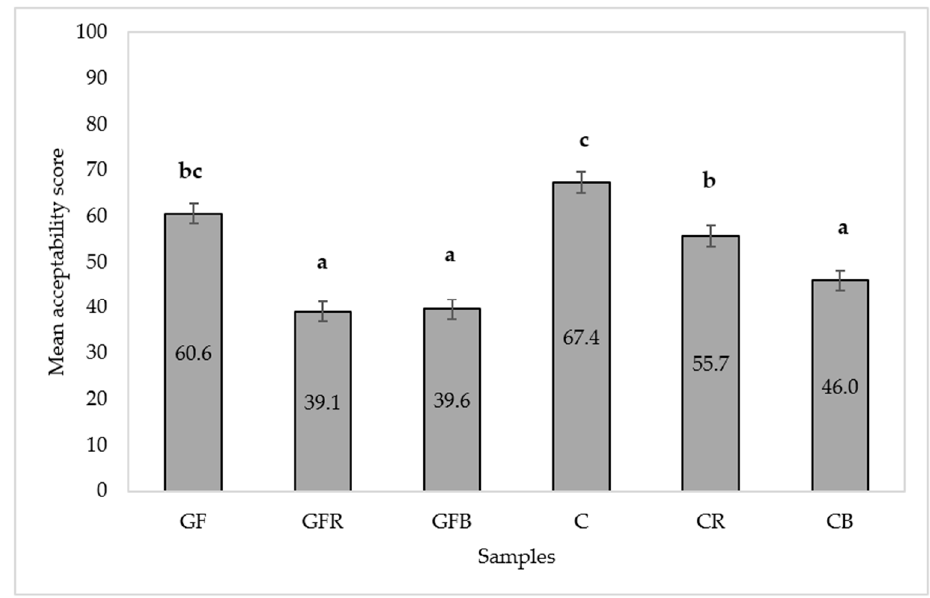
Figure 3. Mean acceptability scores with standard error of the mean. Different letters indicate significant differences according to Least Significant Difference (LSD) post-hoc test.